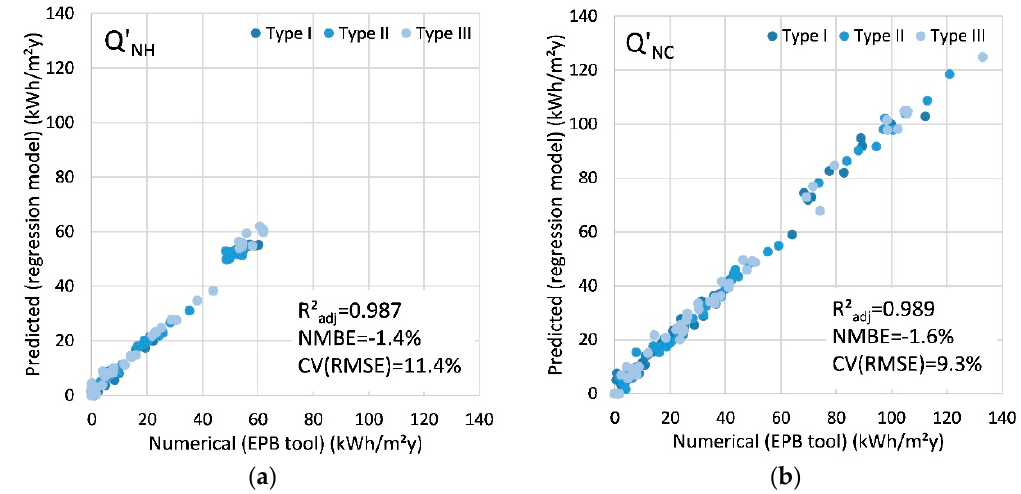
Figure 4. Numerical modelled (with upgraded energy performance of buildings (EPB) tool) and predicted (with regression models) specific yearly energy needs for heating ( a ) and cooling ( b ) of reference buildings presented in Figure 3.